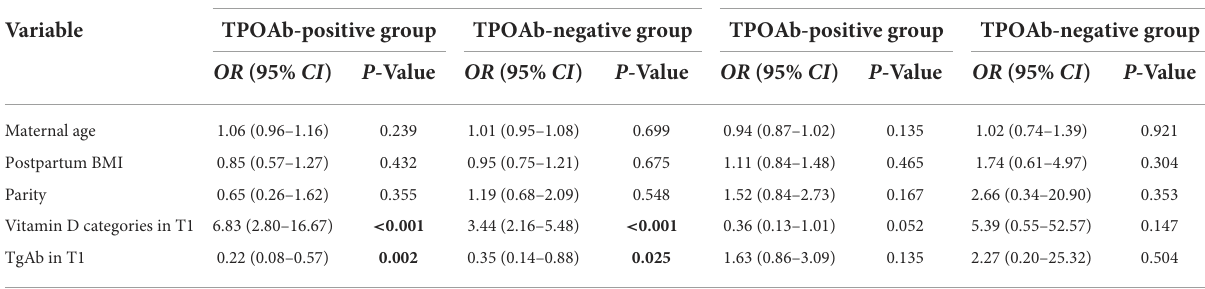
TABLE 5 Multivariate Cox regression analysis of thyroid function in the 6th month postpartum.